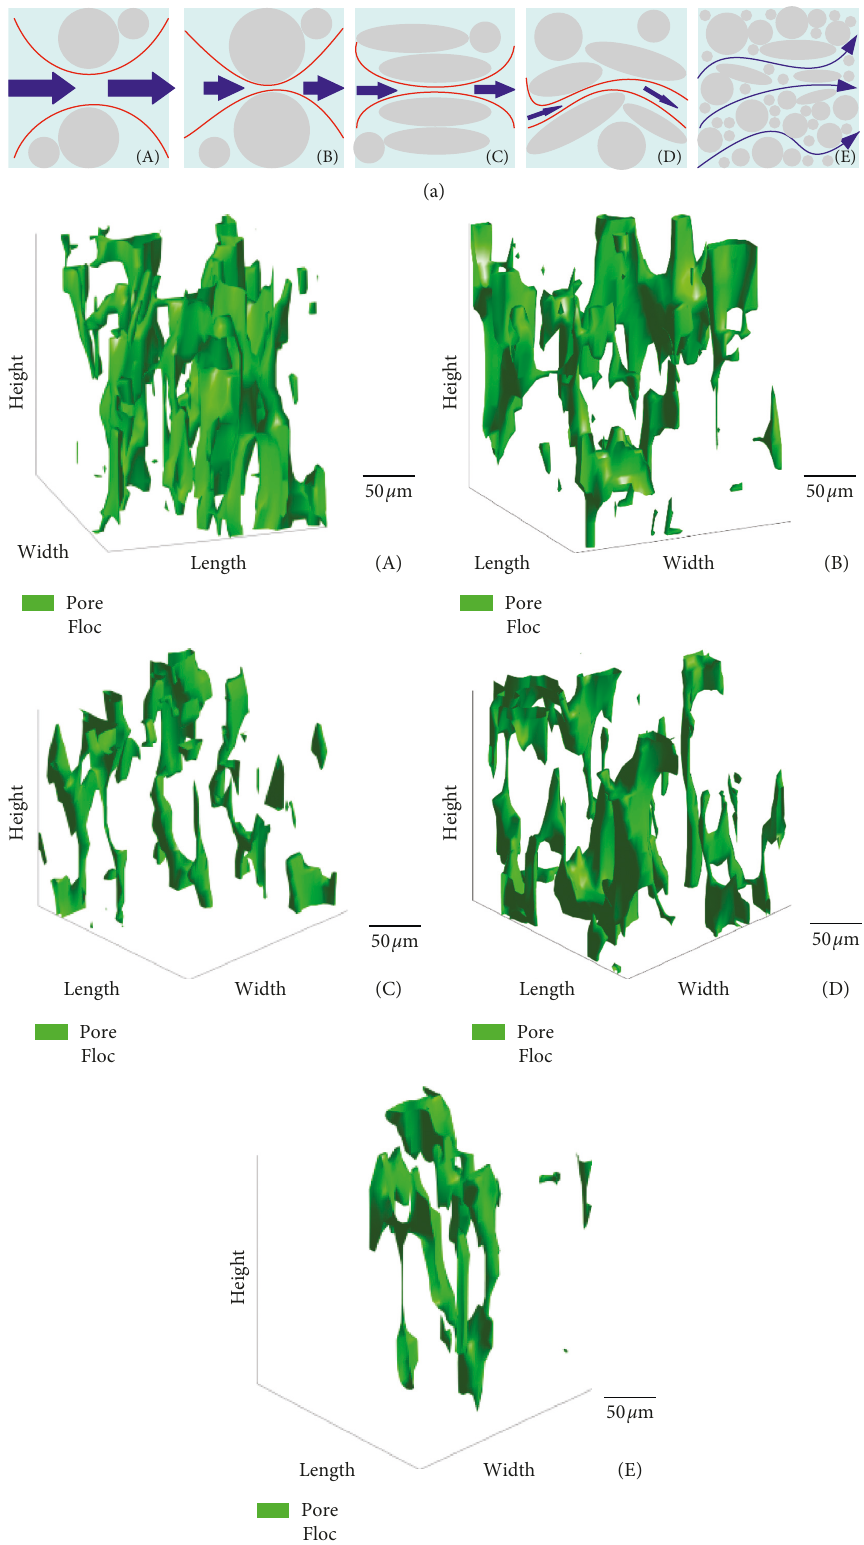
Figure 6: (a) Scheme and (b) three-dimensional reconstruction model of channel classification. (A) Columnar throat channel. (B) Acicular throat channel. (C) Flaky throat channel. (D) Curved flaky throat channel. (E) Capillary fasciculate throat